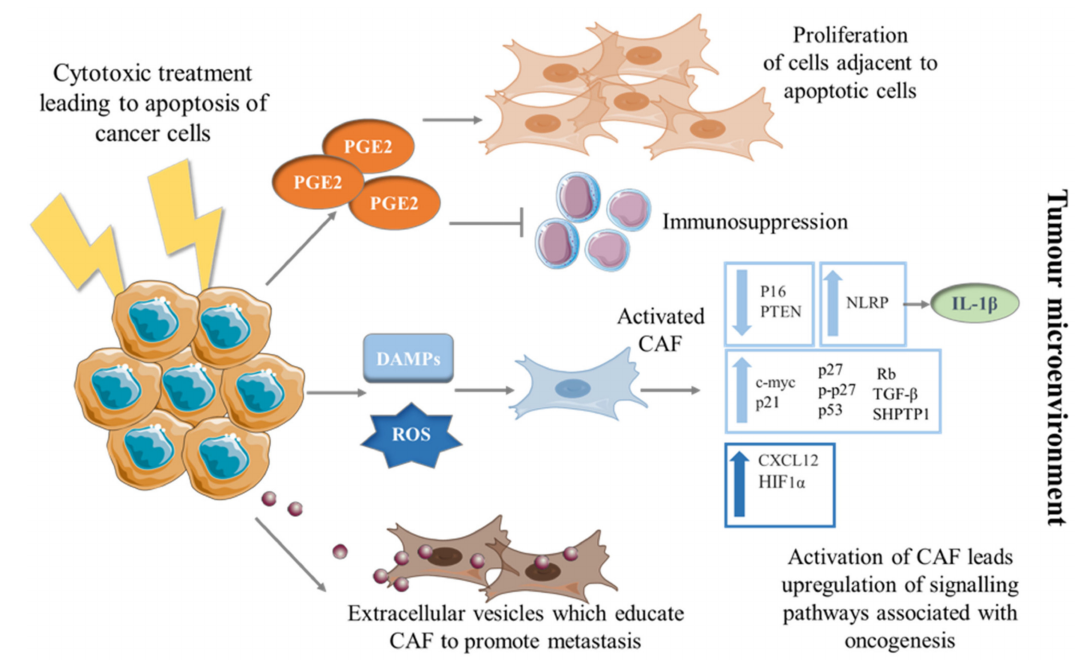
Figure 1. Education of CAF into a pro-tumorigenic phenotype by dying cancer cells. Mechanisms by which CAF can be transformed to a phenotype promoting tumorigenesis via the education of dying cancer cells. Cancer cells undergoing apoptosis secrete PGE2 which in turn can have pro-proliferative and immunosuppressive effects on surrounding cells in the TME. When cancer cells are exposed to cytotoxic therapies, they release DAMPs and ROS which stimulate CAF to differentiate into unfavorable phenotypes; upregulating pathways and secreting molecules associated with progression. Apoptotic cancer cells release EVs which have shown to be taken up by fibroblasts and educate them, resulting in CAF- promoting cancer cell